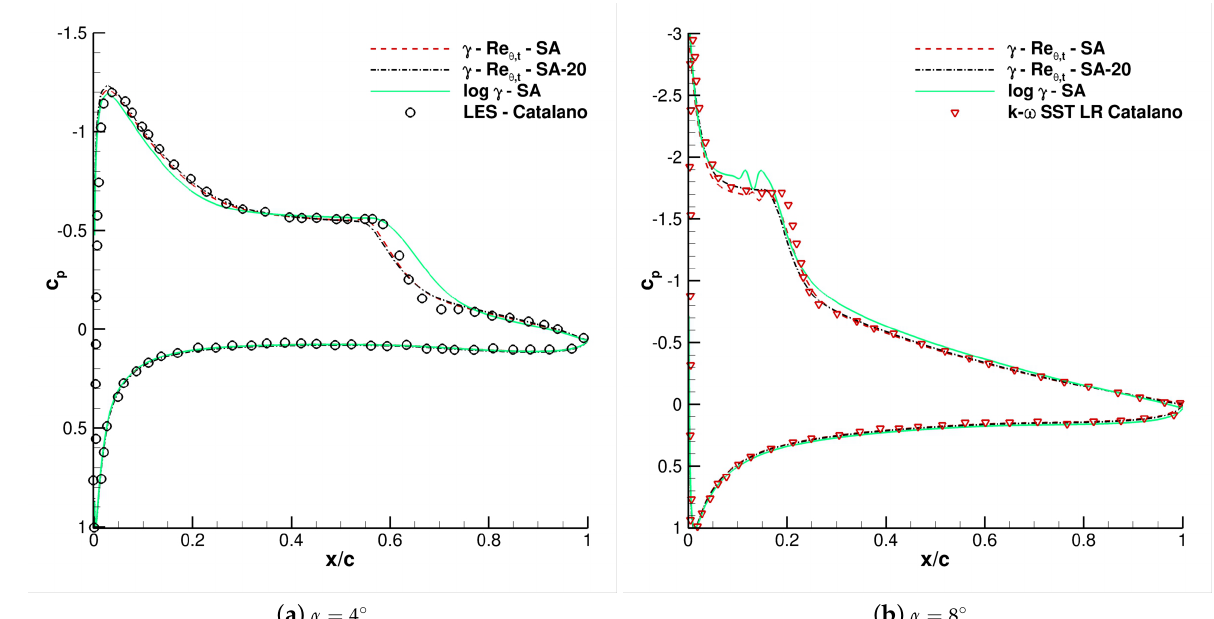
Figure 10. SD7003, Re = 6 × 10 4 . Pressure coefficients, log γ –SA